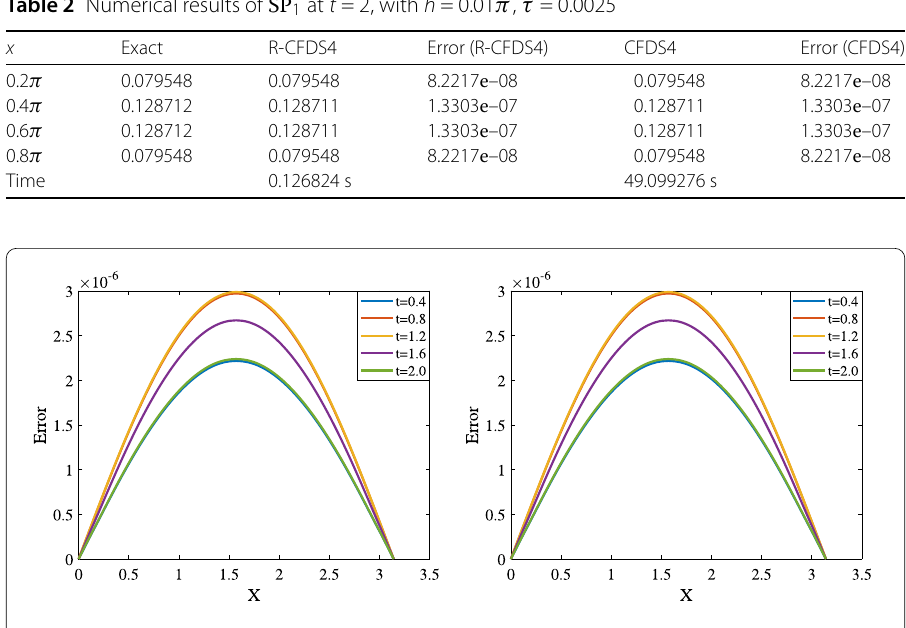
Figure 2 The errors of solutions of R-CFDS4(left) and CFDS4(right) with h = 0.02 π and τ = 0.01 for SP